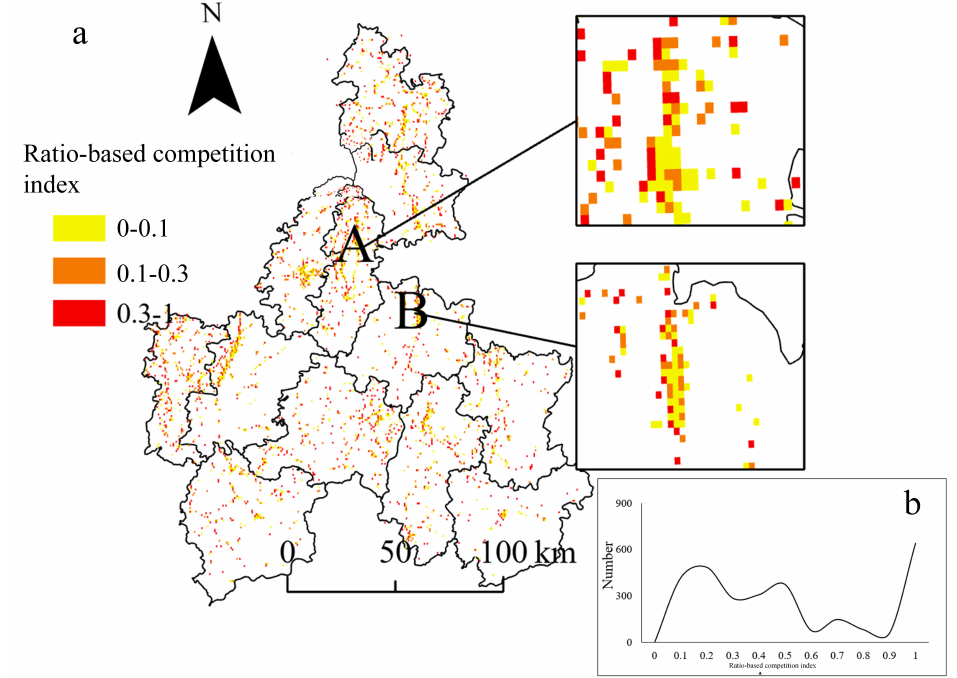
Figure 9. ( a ) Distribution of the ratio-based competition index. ( b ) Relationship curve of the ratio- based competition index and the number of shops in the grid